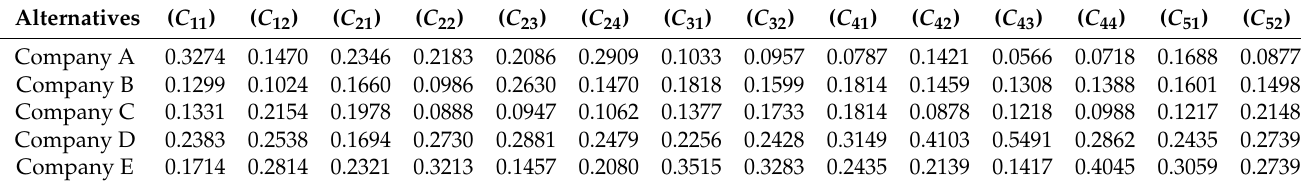
Table 12. Eigenvectors of five alternatives under each criterion.